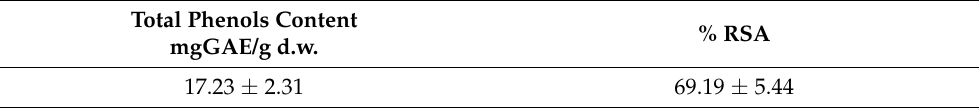
The total phenols content was determined using the Folin–Ciocalteu method and RSA represented Radical Scavenging